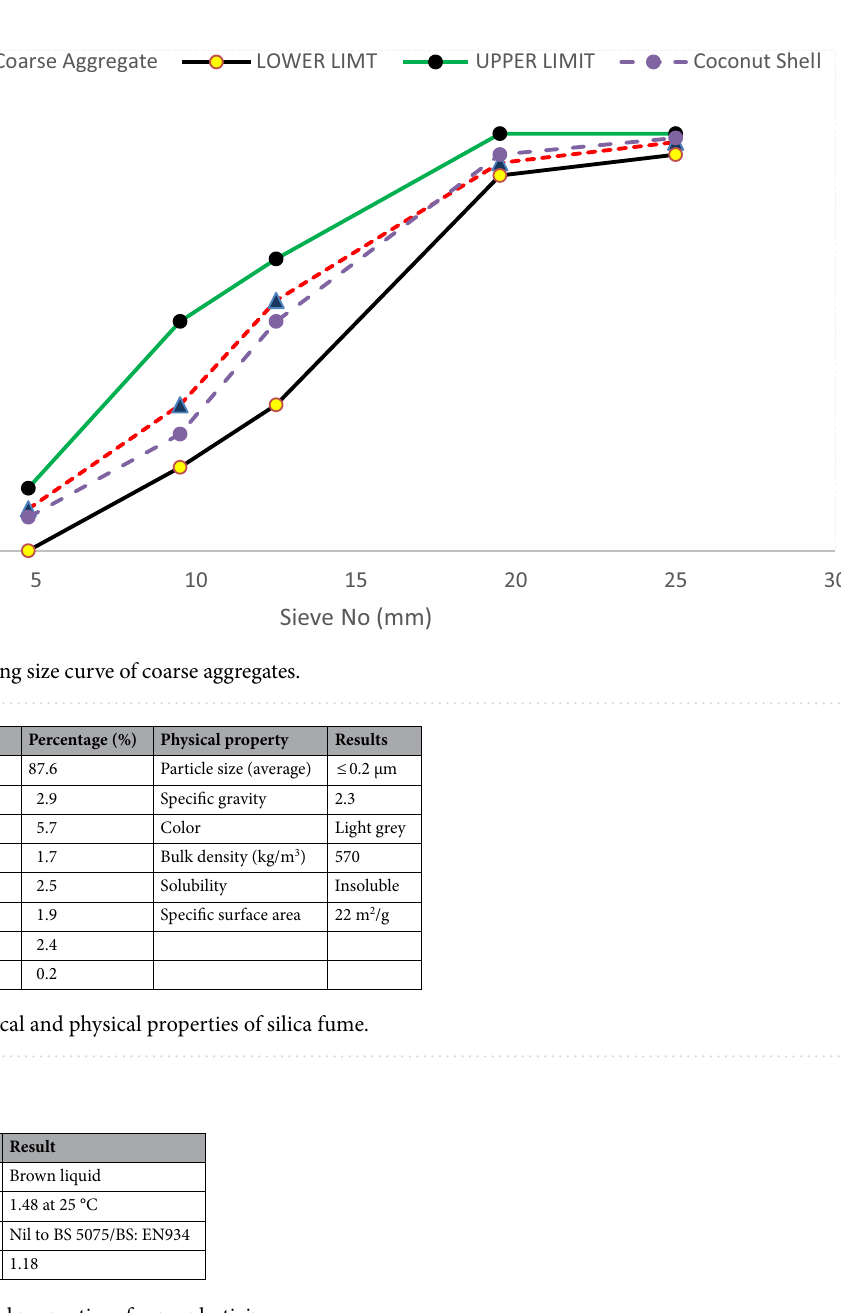
Table 5. Physical properties of